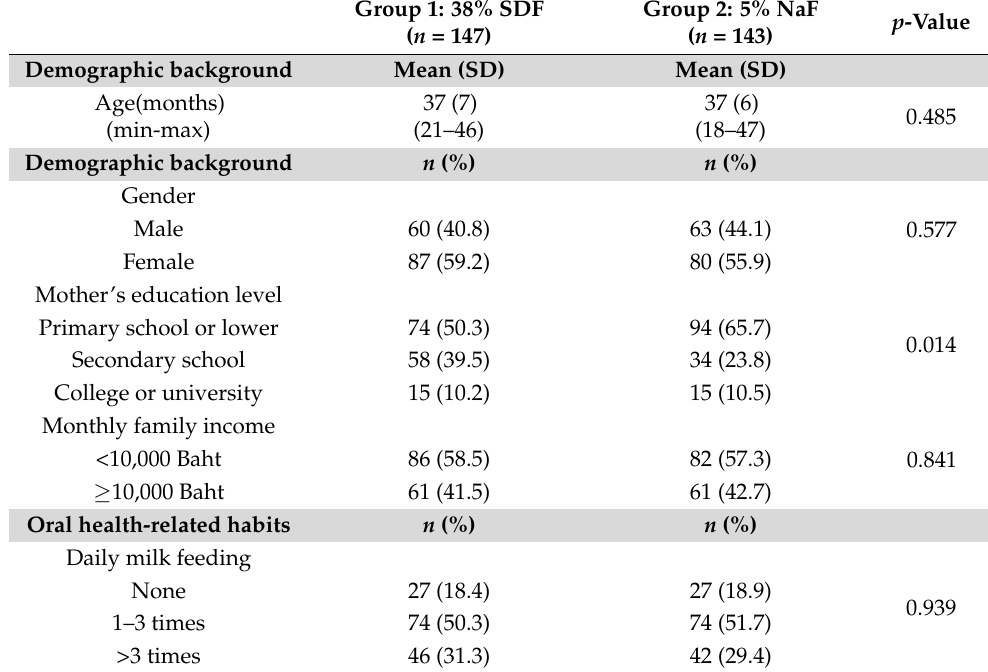
Figure 1. Flow of participants over the 18-month study. Table 1. Socio-demographic background, oral health–related habits, and clinical characteristics of participants at